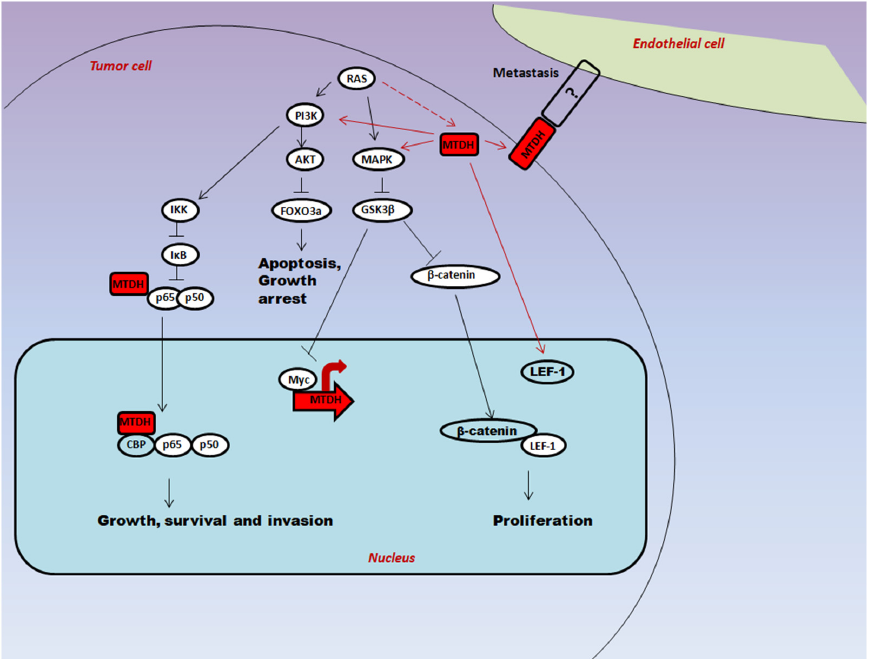
Figure 1. Involvement of AEG-1/MTDH in various signaling pathways (MTDH/AEG-1 enhances cancer progression through integration of several signaling pathways. The oncogenic Ha-ras in- creases MTDH expression through the activation of PI3K/AKT pathway, which phosphorylates and inactivates GSK-3 β and subsequently elevates the stabilization and binding of c-Myc to the MTDH promoter. MTDH can activate AKT, NF- κ B, and Wnt/ β -catenin pathways to promote pro- liferation, survival, and invasion. Solid arrows indicate activation, bar-headed arrows indicate in- hibition and dotted arrows indicate probable mechanism of action) [17].